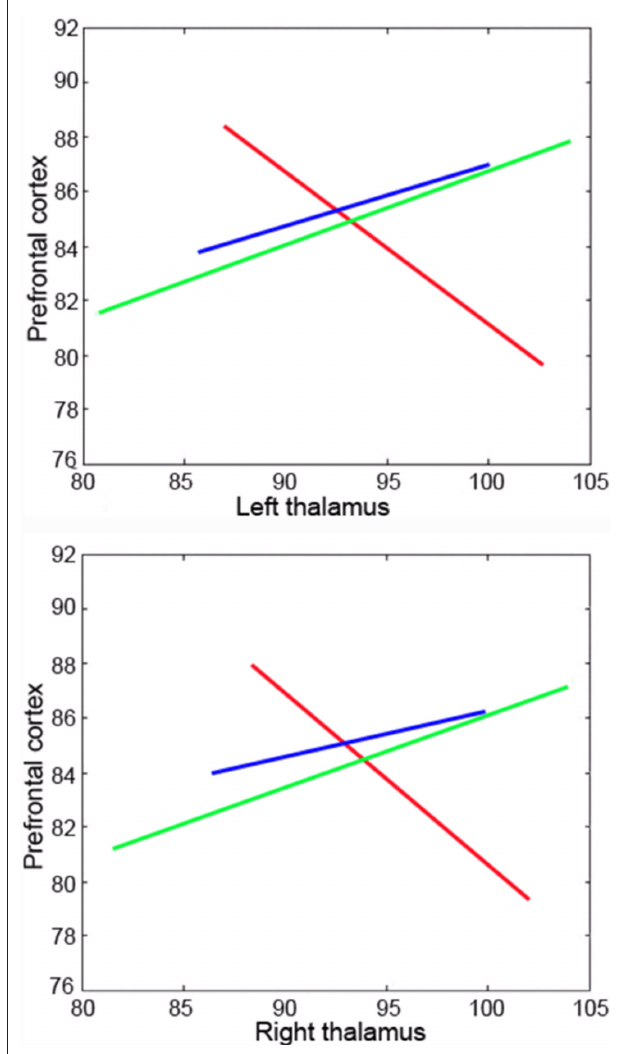
Figure 3 | Functional connectivity between the thalami and prefrontal cortex is abolished during pathological unconsciousness (uWS/VS; red regression line) and resumes a near-normal modulation after recovery of consciousness (blue line). The green line illustrates connectivity in healthy controls. Regression lines represent cross-correlation of normalized regional cerebral blood flow as measured by H O 15 -PET. Adapted from 2 Laureys et al.